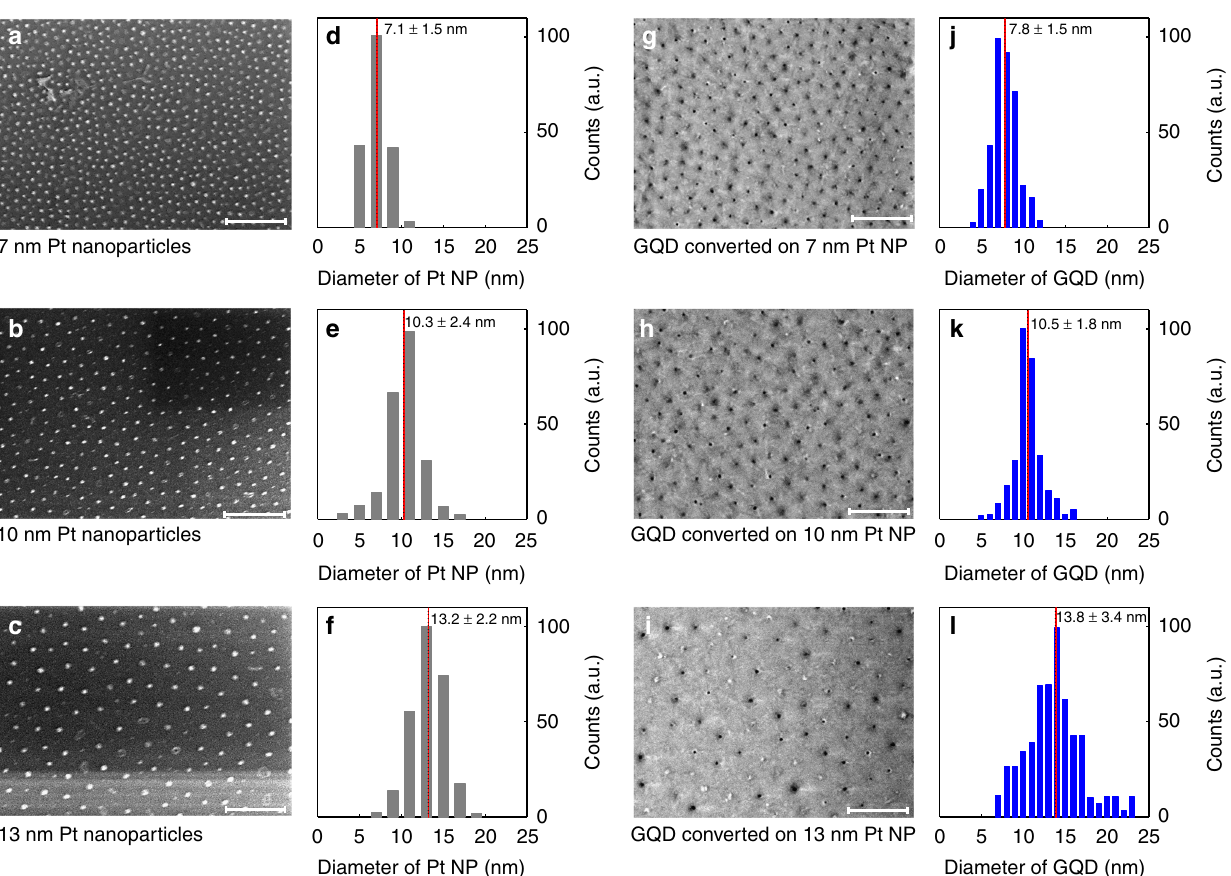
Fig. 2 Size and spatial distribution of the GQDs. a – c , The SEM images of 7, 10 and 13 nm sized self-assembled arrays of Pt NPs on SiO 2 substrates, respectively. Scale bar 300 nm. d – f Corresponding size distribution histograms of Pt NPs on SiO 2 substrates. Numbers give the average (marked by red lines) and the standard deviation. g – i The SEM images of GQD-hBN in-plane heterostructures prepared on pristine SiO 2 . Scale bar 300 nm. j – l Corresponding size histograms of GQD-hBN samples. Numbers give the average (marked by red lines) and the standard